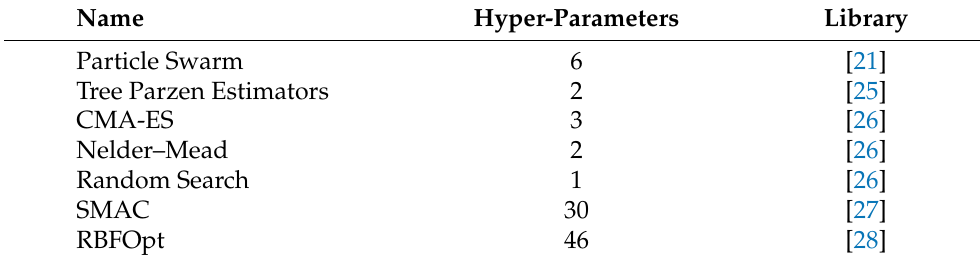
Table 2. Hyper-parameters of the HPO algorithms considered in this